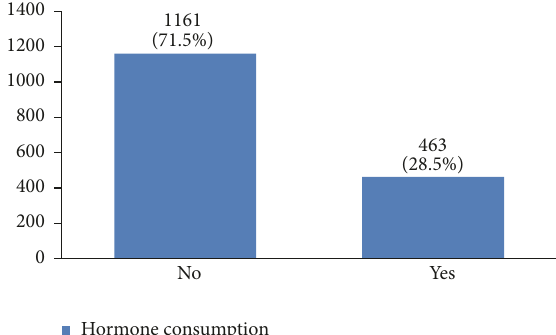
Figure 7: The abortion type of the studied breast cancer cases.